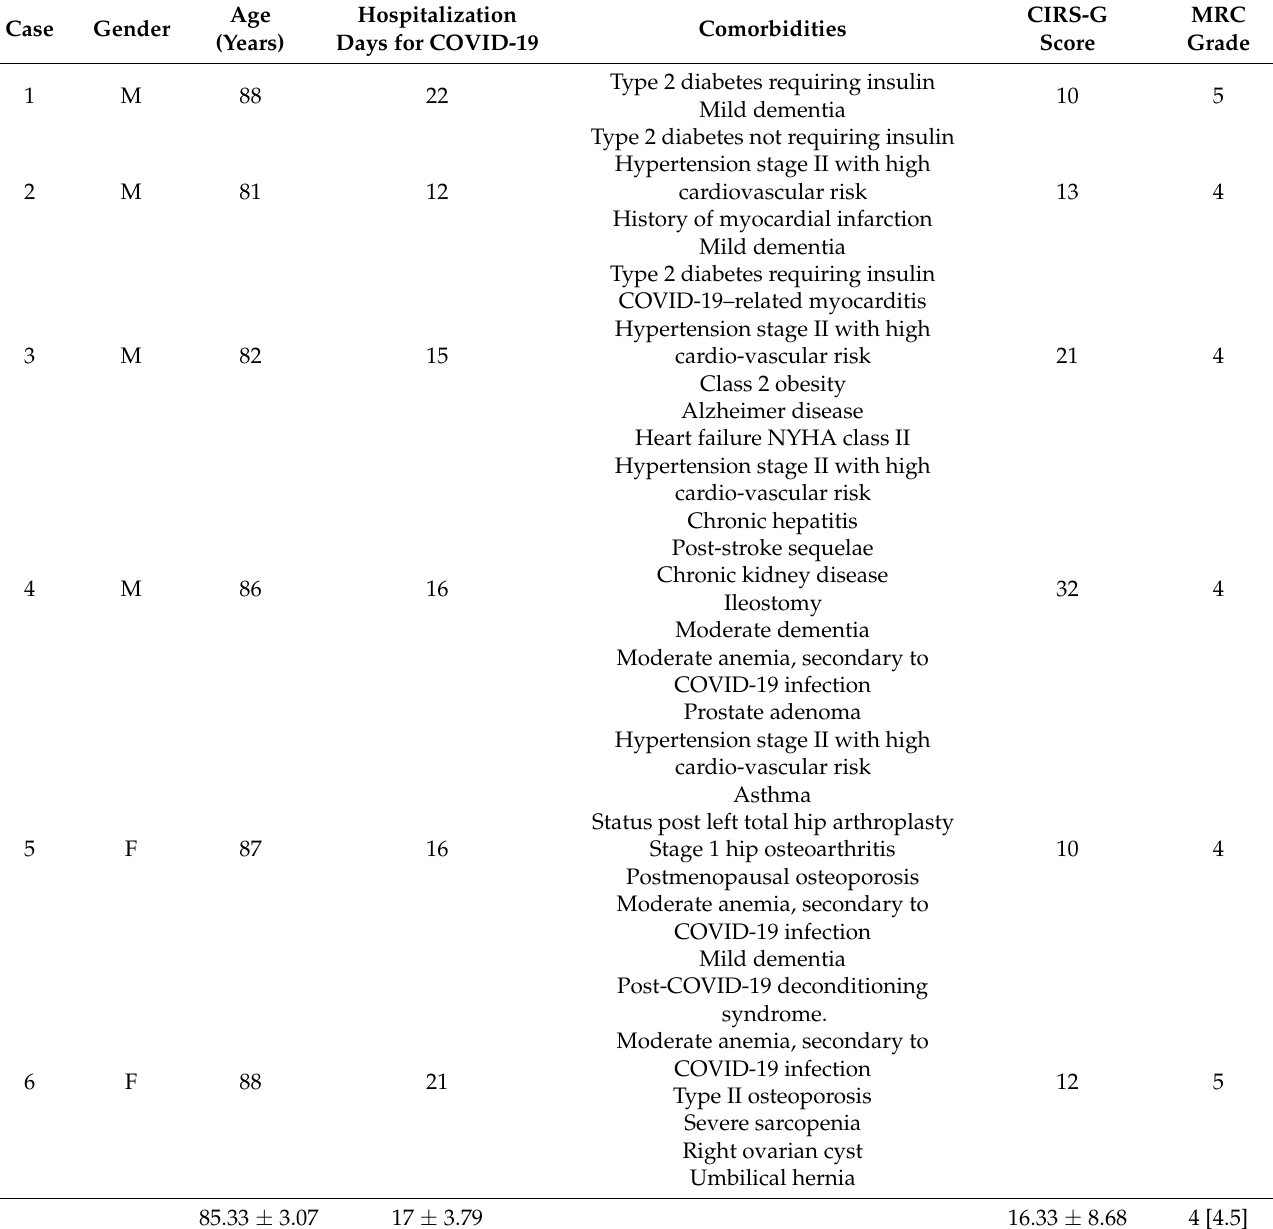
Table 1. Patients’